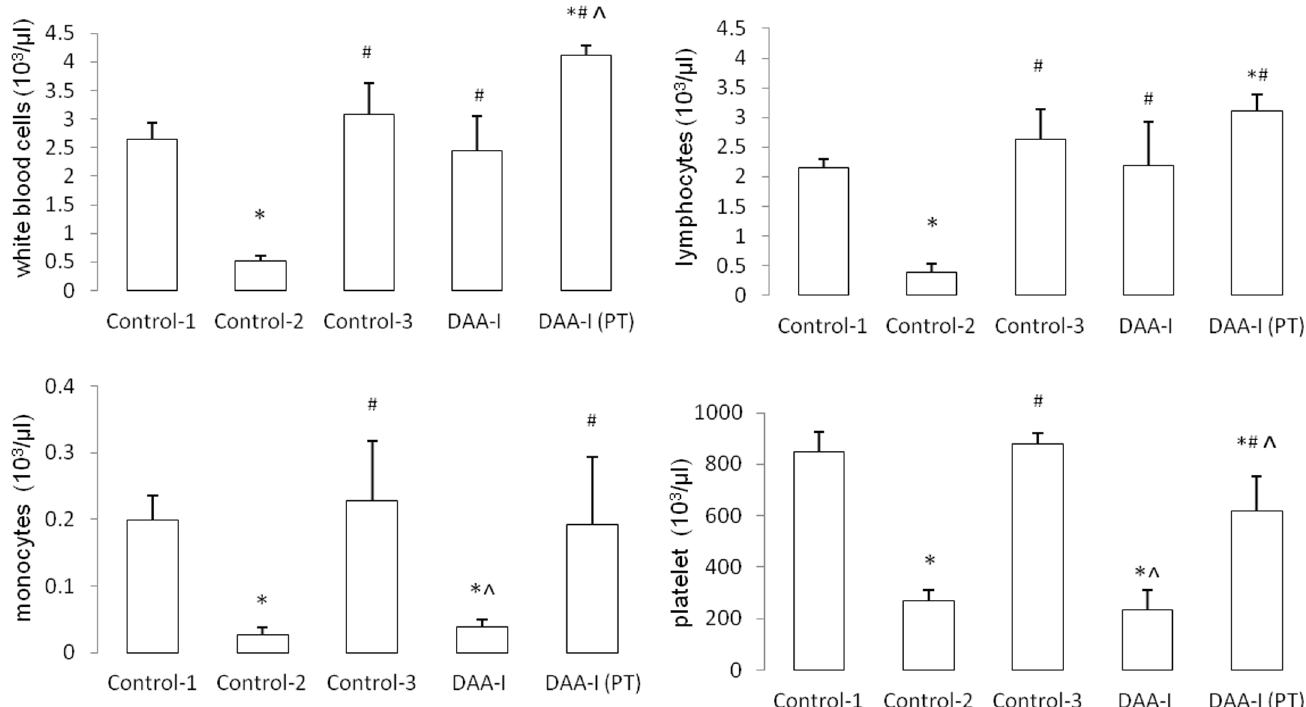
Fig 2. The effects of DAA-I on the profile of leucocytes and platelet in gamma irradiated mice. Control-1: animals were administered 0.1 ml vehicle (water) and were not irradiated. Control-2: animals were administered vehicle and were irradiated. Control-3: animals were administered 800 nmole/kg DAA-I and were not irradiated. DAA-I: animals were administered 800 nmole/kg DAA-I and were irradiated. DAA-I(PT): animals were administered 800 nmole/kg DAA-I for 14 days before TBI and a further 15 days post TBI. Each value is a mean ± S.E.M. obtained from 3 mice. Comparisons between groups was analyzed by One-Way ANOVA followed by Tukey ’ s post-hoc test. * p < 0.05 vs Control-1. # p < 0.05 vs Control-2. ^ < 0.05 vs